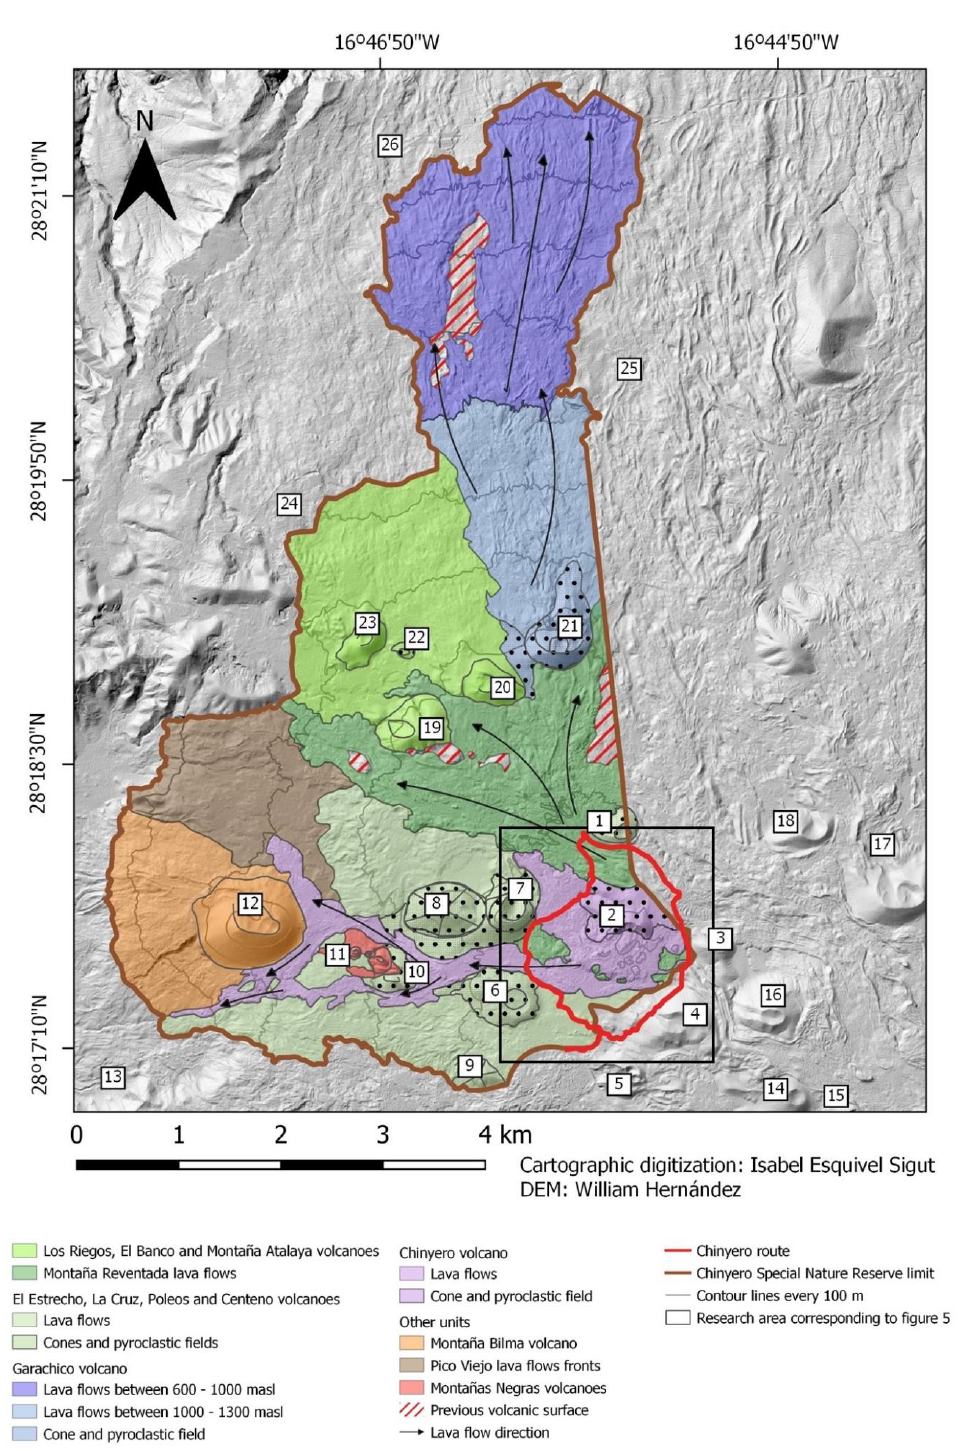
Figure 6. Landscape units of the Chinyero Special Nature Reserve. Source: IDE-Canarias, self-elaboration. 1. Montaña de las Flores - 2. Chinyero - 3. Montaña Chica de Abeque - 4. Montaña la Corredera - 5. Boca Cangrejo - 6. Montaña de los Poleos - 7. Montaña de La Cruz - 8. Montaña del Estrecho - 9. Montaña del Centeno - 10. Montaña Aguda - 11. Montañas Negras - 12. Montaña Bilma - 13. Las Manchas - 14. Montaña Chica de las Cuevitas - 15. Montaña Grande de las Cuevitas - 16. Montaña Grande de Abeque - 17. Calzada de las Arrambleras - 18. Montaña Liferfe - 19. Montaña Los Riegos - 20. Montaña de la Atalaya - 21. Montaña Negra (Arenas Negras / Garachico) - 22. Montaña de las Caballerizas - 23. Montaña del Banco - 24. San Jos é de Los Llanos - 25. La Montañeta - 26. El